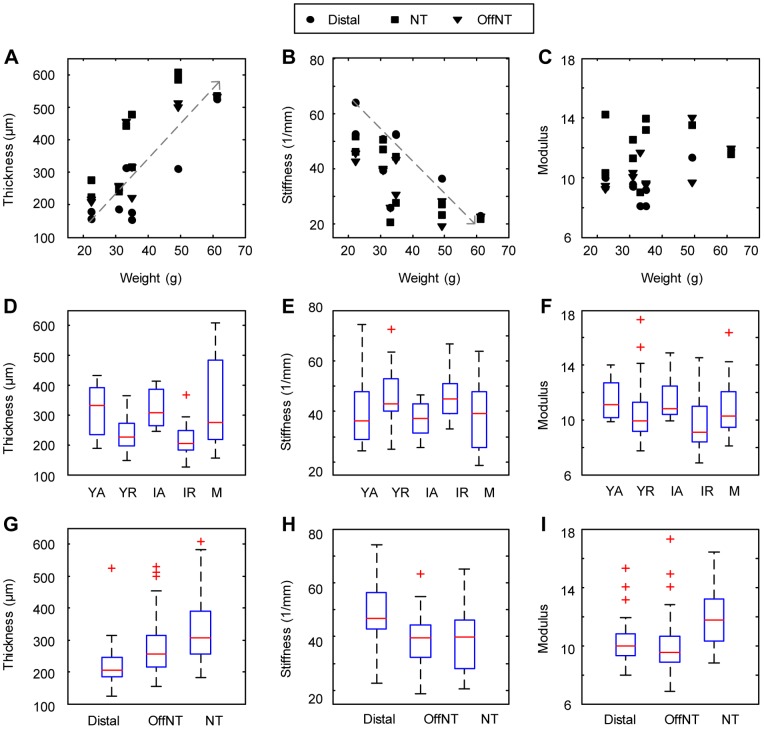
Skin properties under compression measured across weight, hair cycle and skin location.Body weight for mature mice plotted versus skin thickness (A), stiffness (B) and elastic modulus (C). Linear regression (dotted lines) indicate that body weight is significantly correlated with skin thickness (r = 0.793, p-value<10−6), inversely correlated with skin stiffness (r = −0.717, p-value<10−3) and uncorrelated with modulus. Skin mechanical parameters are shown with respect to hair cycle stages (D–F) and skin site (G–I). Statistical significance was assessed by Pearson test of correlation and unpaired Student's t test and results are given in Tables 1 and 2. For all plots, boxes range from lower to upper quartiles, red lines within boxes indicate medians, black lines outside of boxes indicate max. and min. values and red (+) indicate outliers beyond 1.5 interquartile range.